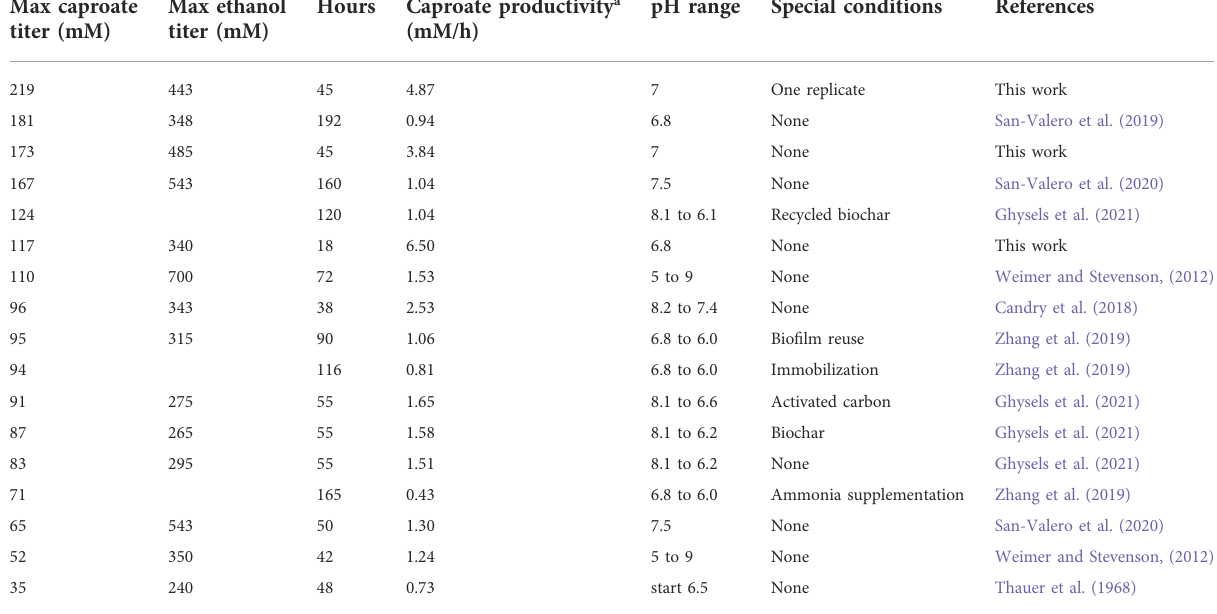
TABLE 1 Caproate titers and production rates of Ckl monocultures.